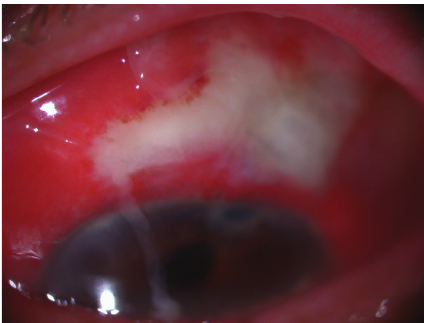
Figure 1: Anterior segment photography in patient with bleb- related endophthalmitis. BRE symptoms including hyperemia, pain, discharge, hypopyon, and loss of vision and the BRE diagnosis were identified as infectious inflammations spread to the vitreous body with white